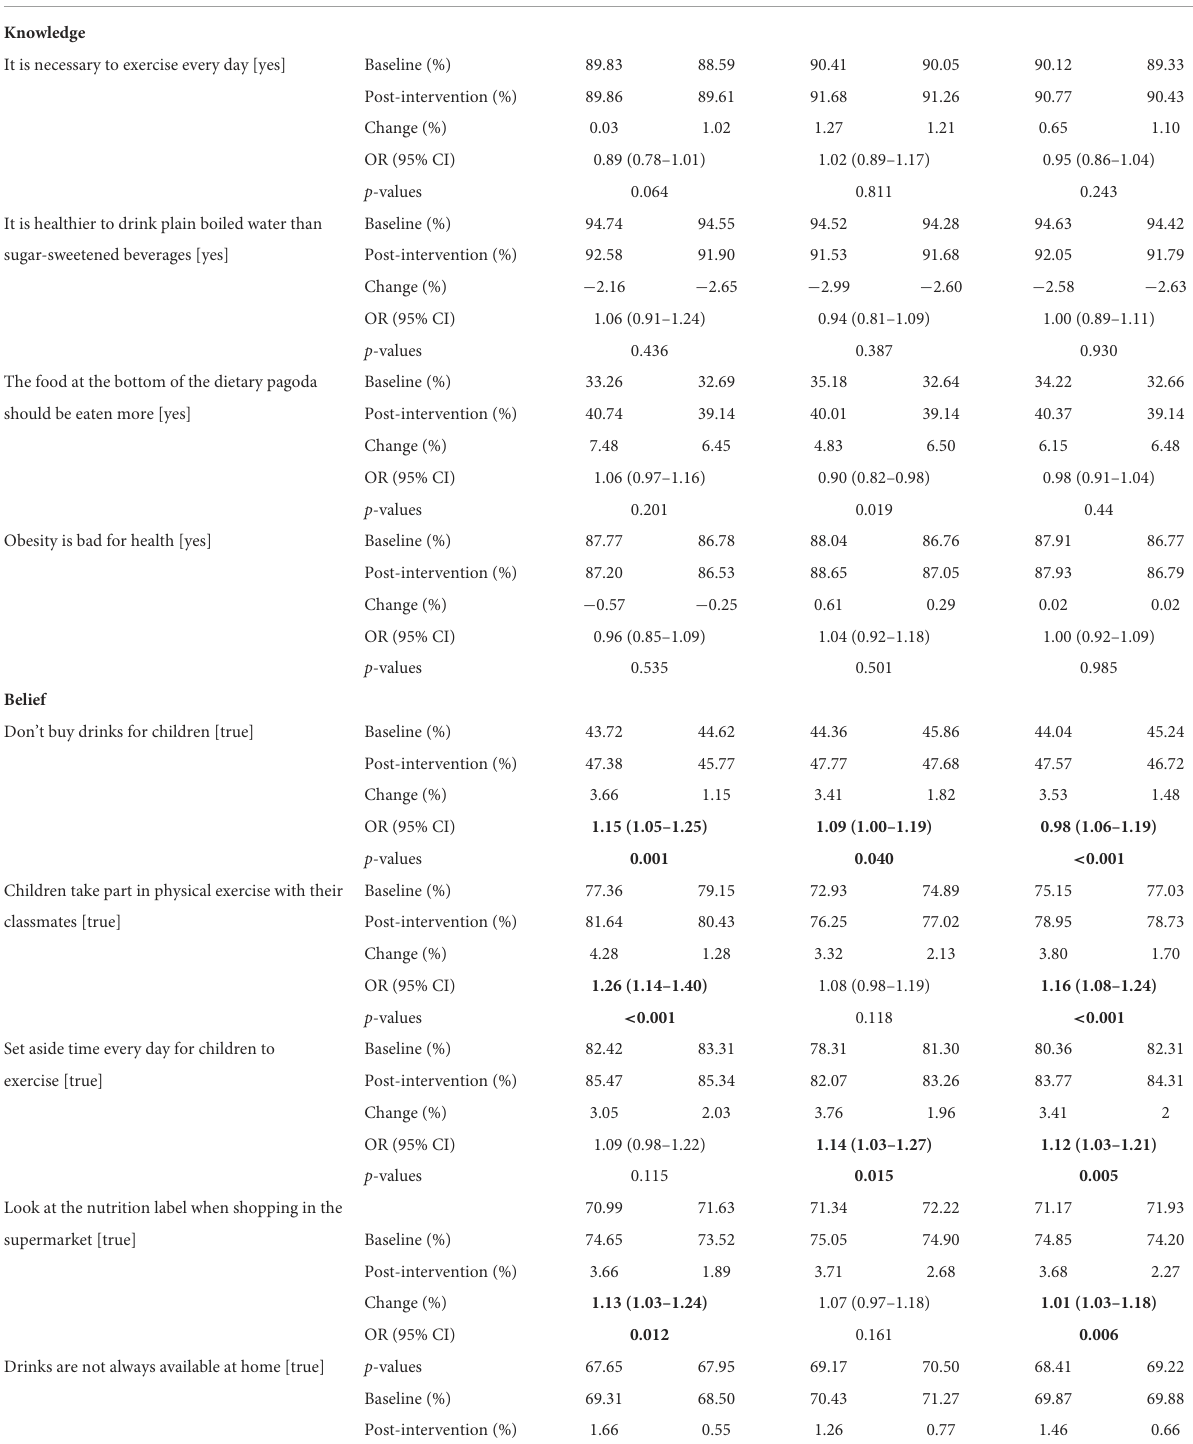
TABLE 4 Effectiveness of intervention on the parents’ knowledge, belief, and practice.